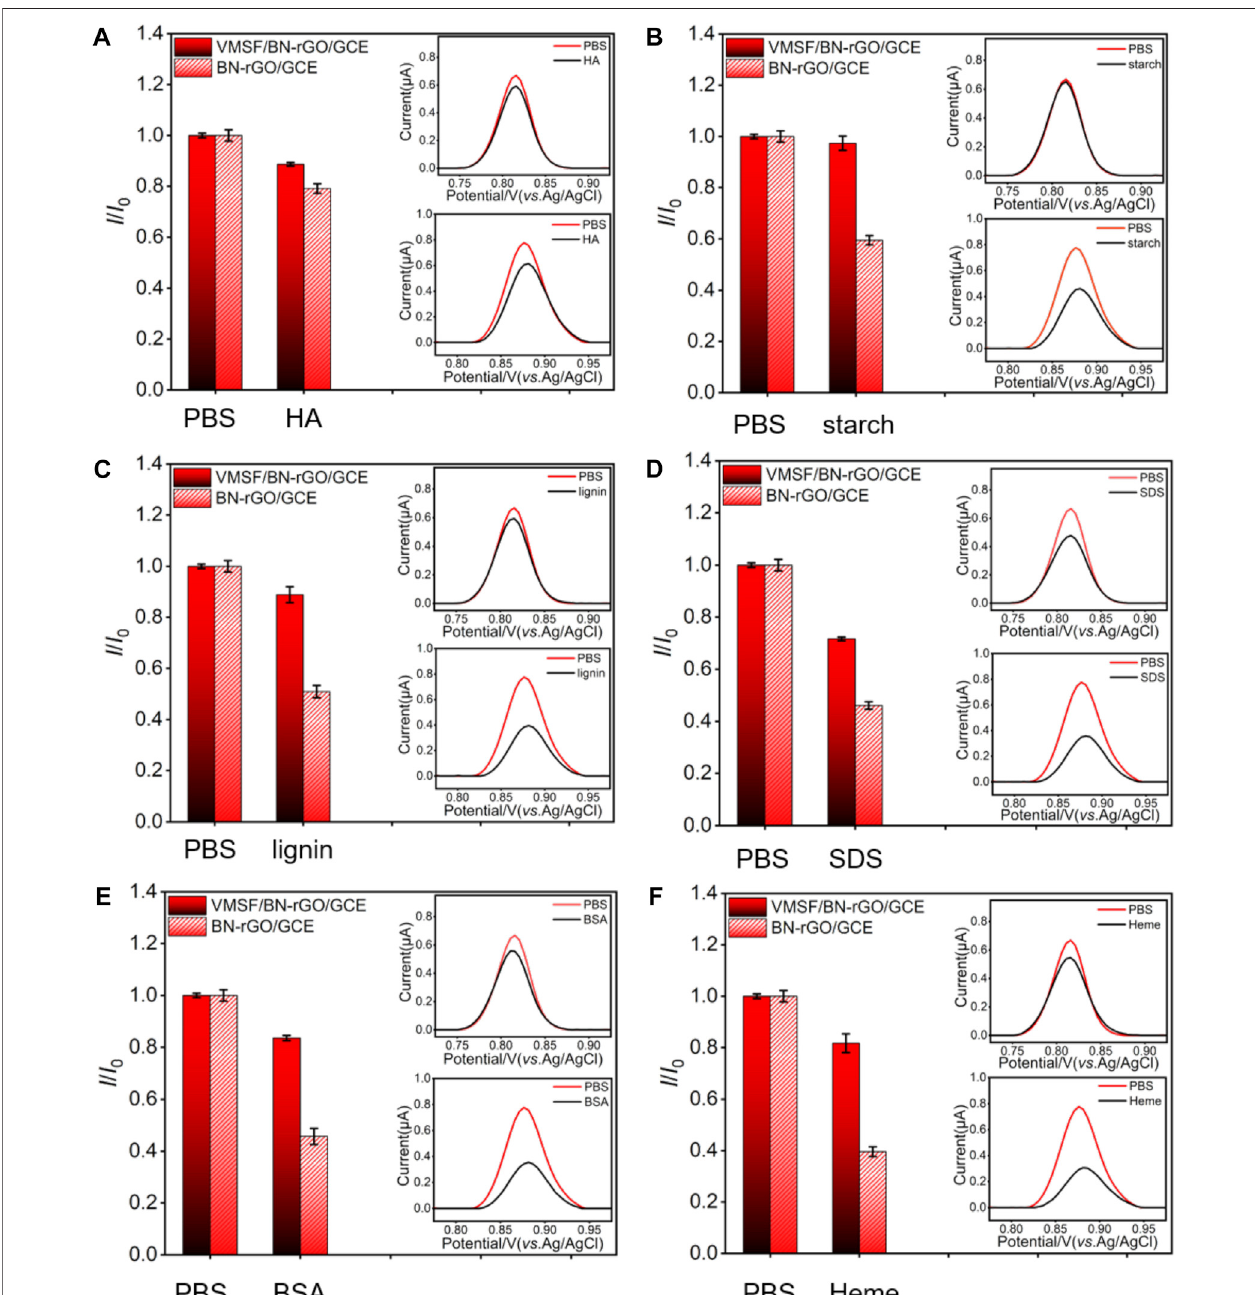
FIGURE 6 | Current ratio ( I / I 0 ) obtained from VMSF/BN-rGO/GCE and BN-rGO/GCE for the detection of 1 μ M CBZ in 0.1 M PBS containing 50 μ g/ml HA (A) , starch (B) ,lignin (C) ,SDS (D) ,BSA (E) ,orHeme (F) .InsetsarecorrespondingDPVcurvesofVMSF/BN-rGO/GCE(redline)andBN-rGO/GCE(blackline)intheabsence (top) or presence (bottom) of fouling species. The error bars represent the SD of three measurements.